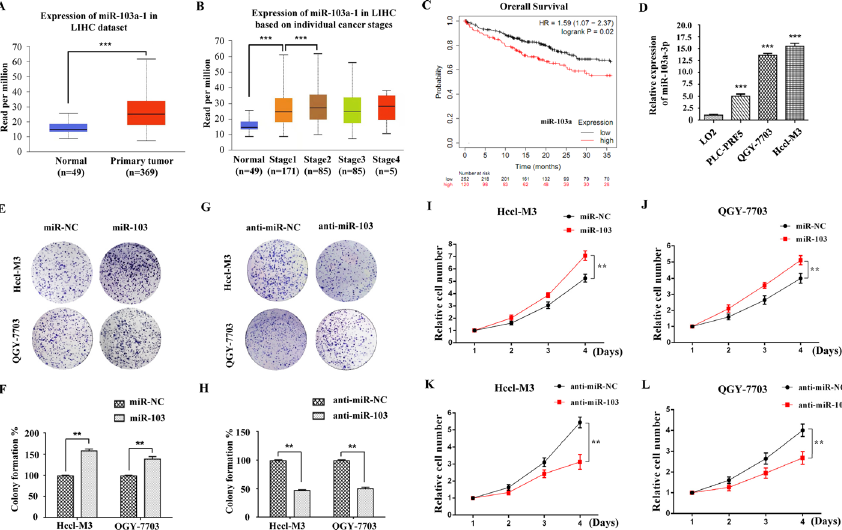
Fig. 3 The prognostic significance of miR-103a in patients with HCC and miR-103a-3p promotes HCC cells proliferation. A Expression of miR-103a-3p in 369 hepatocellular carcinoma (HCC) tumor samples versus 49 normal liver tissues. Data were obtained from TCGA and log2(TPM 1) was used to present expression level. + TPM, transcripts per million reads. B Expression of miR-103a-3p in a cohort of HCC patients with different cancer stages. C Overall survival was compared between patients with HCC with a high expression level of miR-103a and those with a low level of miR-103a. D RT-qPCR analysis of miR-103a-3p levels in L02 cells and HCC cell lines. *** P < 0.001 vs L02 group. E – L Hccl-M3 and QGY-7703 cells were transfected with